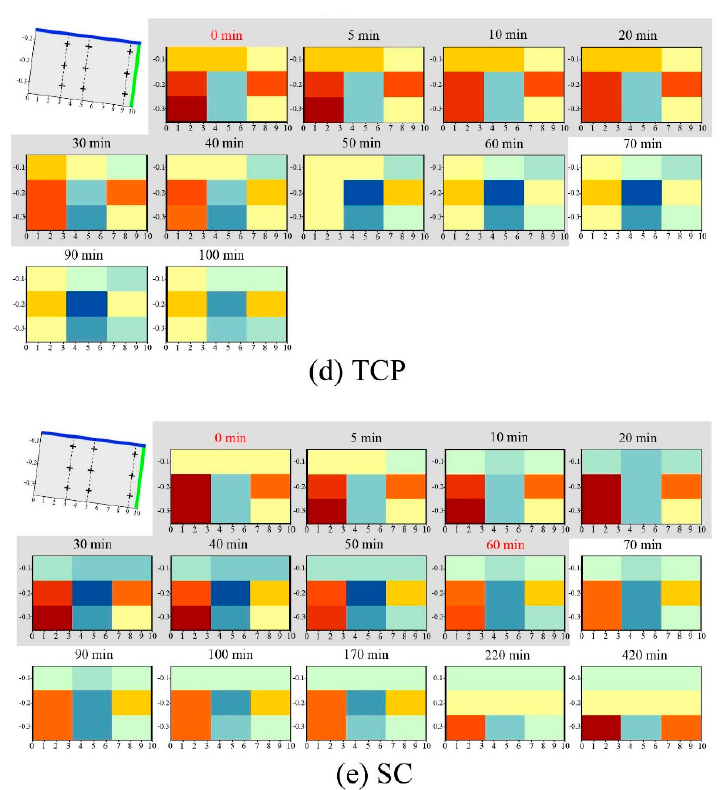
Figure 11. The dynamic distribution of VWC in soil profile under different vegetation cover and tillage conditions. Table 3. Changes in the VWC of the soil at various depths before and after